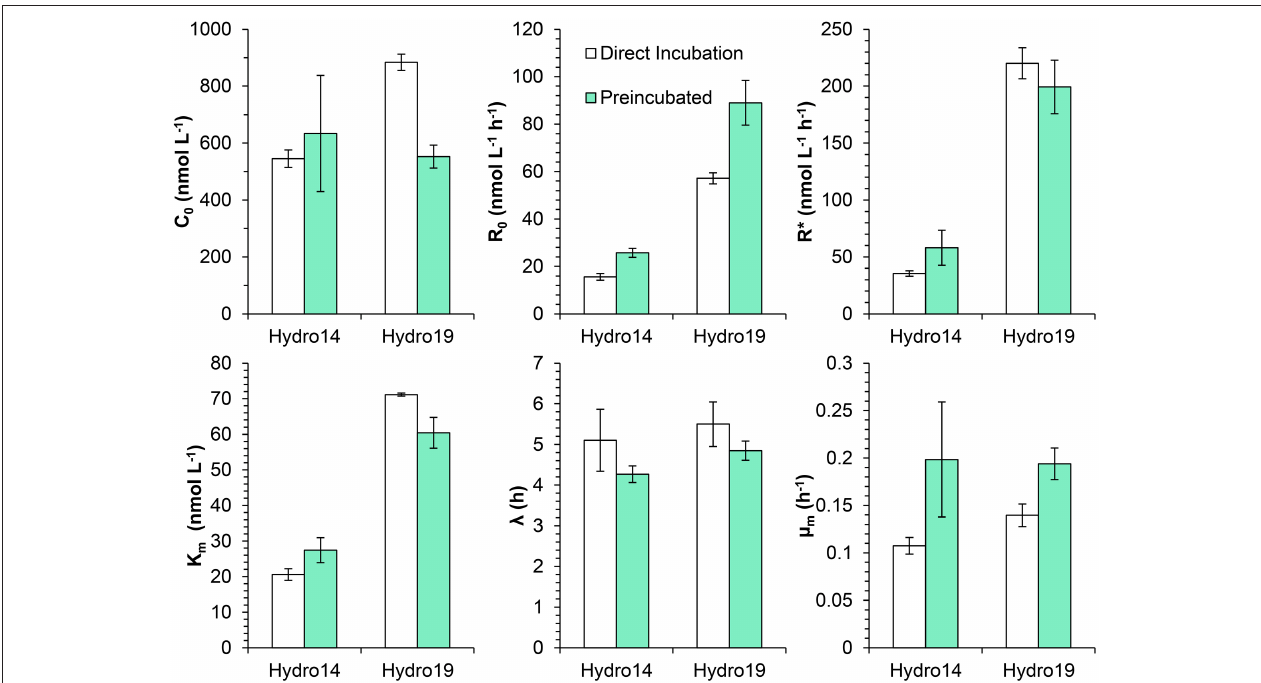
FIGURE 7 | Effect of bubbling with inert gas on the respiratory parameters during the incubation of surface waters from stations Hydro 14 and 19 in the ETSP OMZ off Chile/Peru: Initial O 2 concentration ( C 0 ), initial respiration rates ( R 0 ), maximum respiration rate ( R *), half saturation constant ( K m ), lag-phase ( λ ), and maximum specific growth rate ( µ m ) measured during the incubations. Samples were sparged with inert gas to lower the O 2 concentration and incubated with constant stirring (Direct incubation) or kept in the degassing bottle for 7–9h prior to the transference to the incubation bottles (Pre-incubated). Note, the different scales for R 0 and R *.